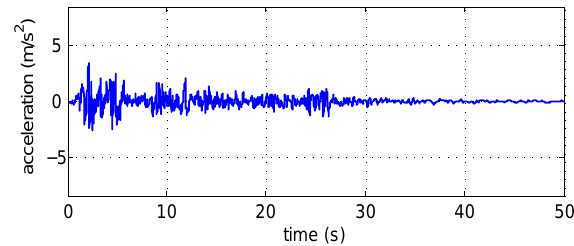
Figure 7: Full scale North-South El Centro 1940 seis- mic record, with an absolute acceleration peak of 3.42 m/s